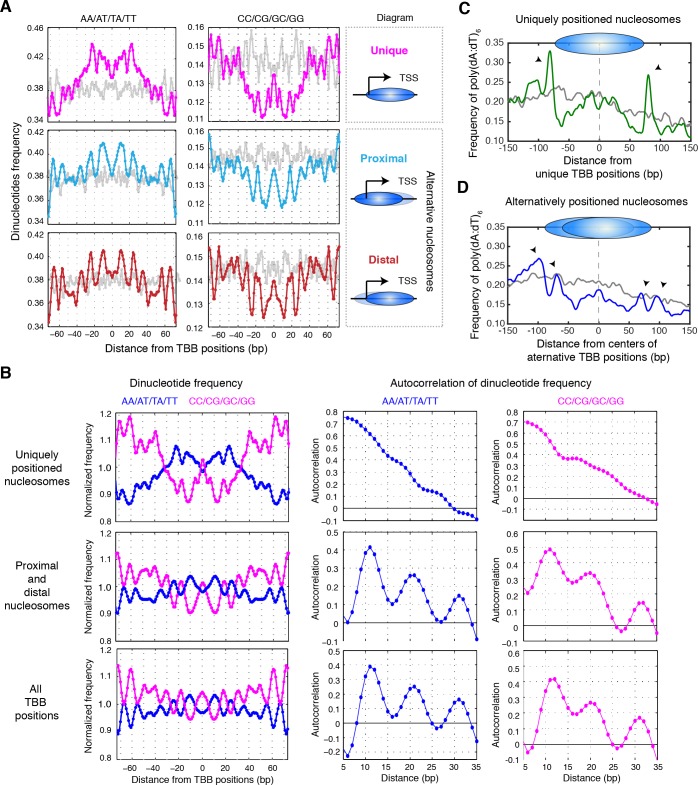
Sequence features of uniquely and alternatively positioned nucleosomes.(A) Plots showing the frequency of AA/AT/TA/TT and CC/CG/GC/GG dinucleotides of DNA sequences aligned at the TBB nucleosome positions of either unique, proximal or distal nucleosomes at gene promoters (illustrated by the diagrams). (B) Plots showing the normalized dinucleotide frequency (smoothed with a 3 bp window) of DNA sequences aligned at unique nucleosomes, alternative nucleosomes (proximal + distal) at gene promoters or all TBB nucleosome positions, and the autocorrelation analysis (performed in MATLAB) of the dinucleotide frequency within nucleosome core (−73–73 bp). (C,D) Plots showing the frequency of poly(dA:dT)6 sequences aligned at unique nucleosomes or the average centers of alternatively positioned nucleosomes. The positive direction of the x-axis indicates 5’ to 3’ for all transcripts. Black arrows mark the enriched poly(dA:dT)6 signals. Overall, 1172 genes contain unique nucleosomes and 3469 genes contain proximal and distal nucleosomes at their promoters. Gray traces present the analysis for a random permutation control of selected promoters and the location of nucleosome positions (A,C,D). The number of these random locations matches the number of nucleosomes in each plot.